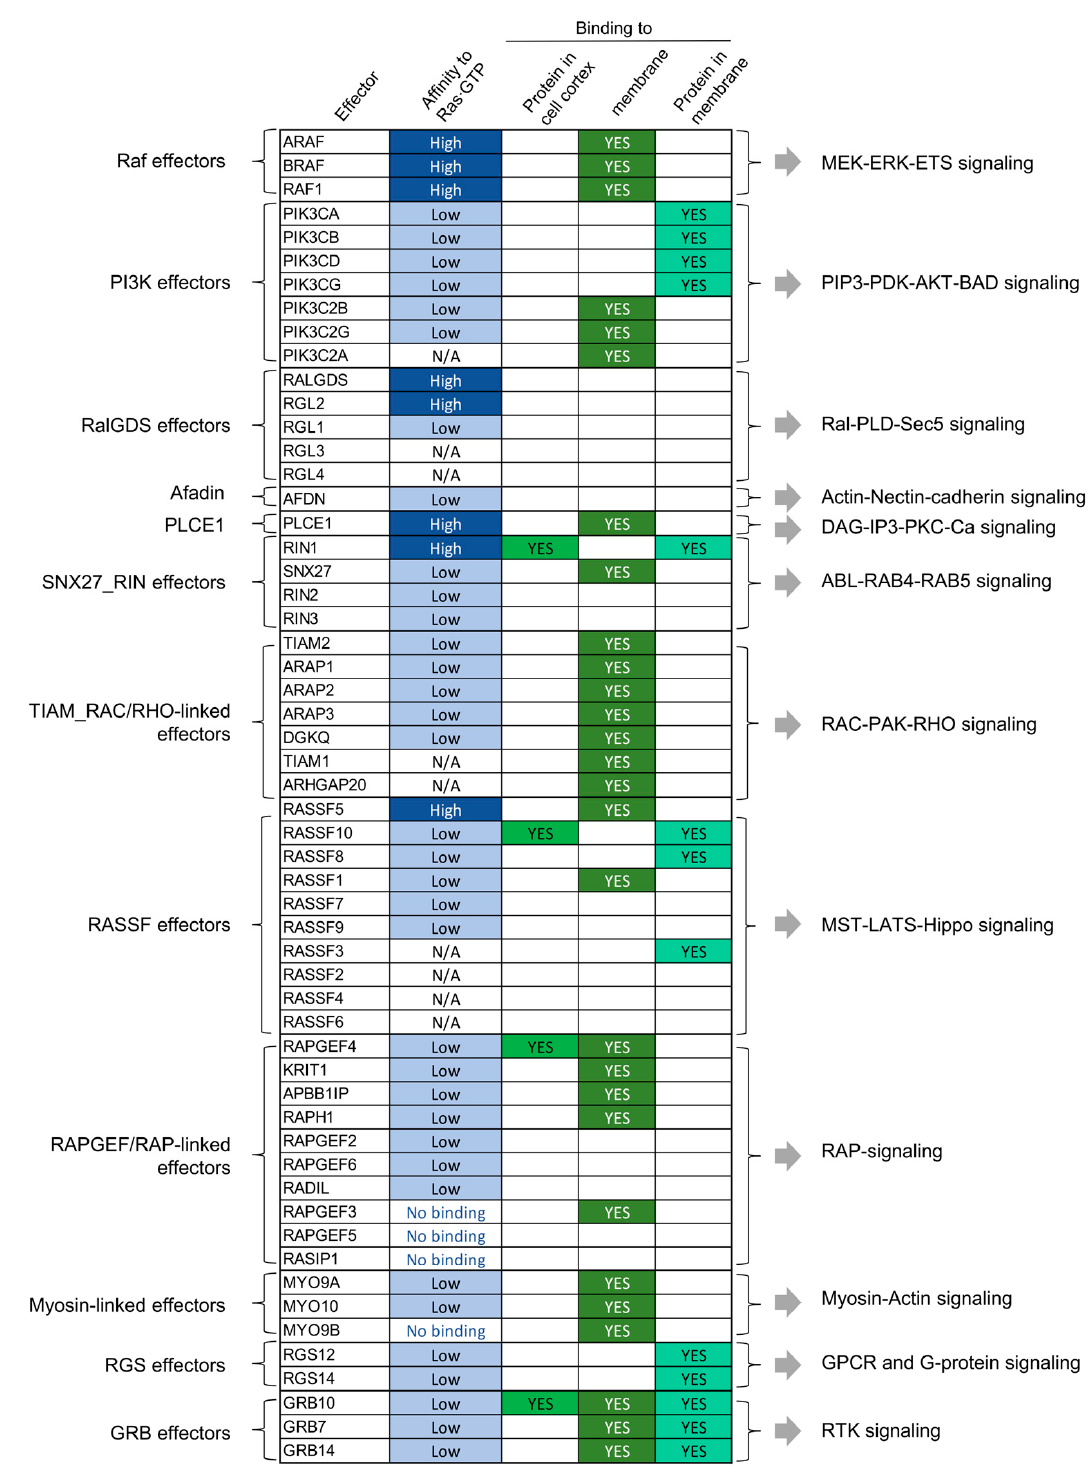
Figure 4. Summary of PM recruitment of 56 effectors grouped into 12 effector pathways. Classification of effectors into 12 effector pathways [17] and summary of the proposed membrane recruitment mechanisms (based on Figures 2 and